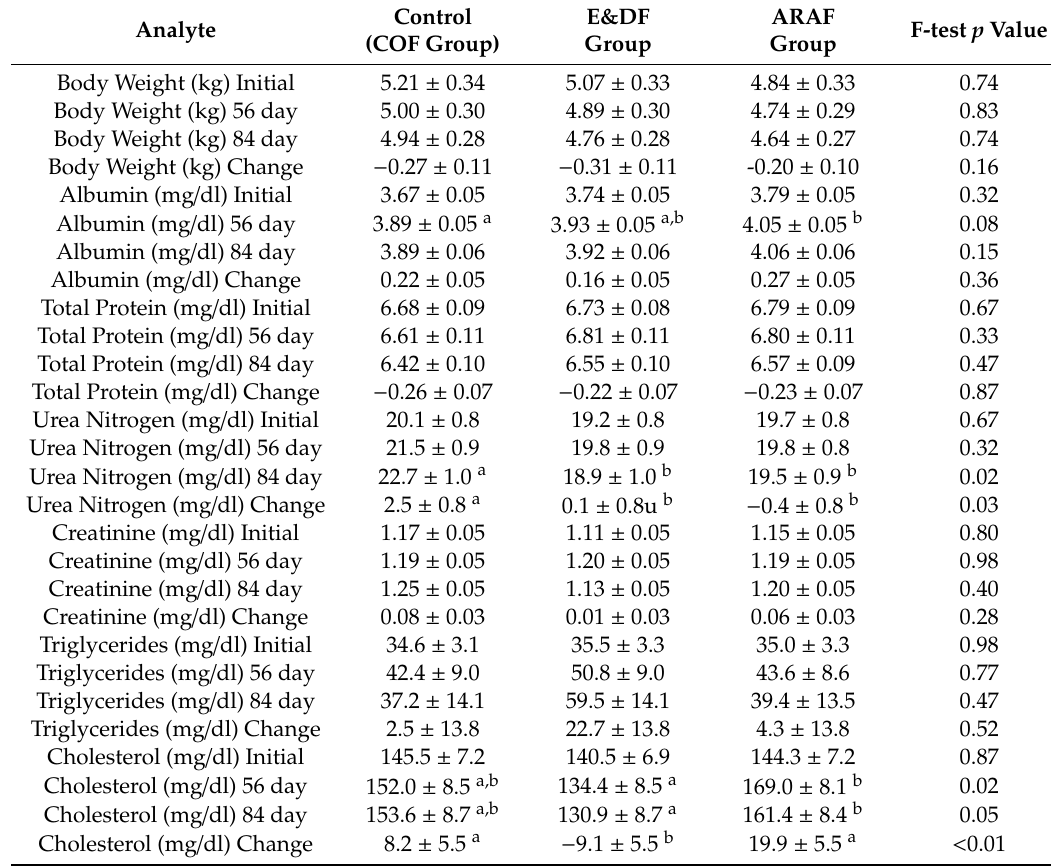
Table 2. Body weight and selected serum biochemistries from cats eating control food (COF), or test (E&DF) COF enhanced with EPA and DHA from fish oil, or test food 2 (ARAF) COF enhanced with arachidonic acid from chicken liver, at initial, 56 days, 84 days of test and change ± during the study (values are lsmeans ± standard